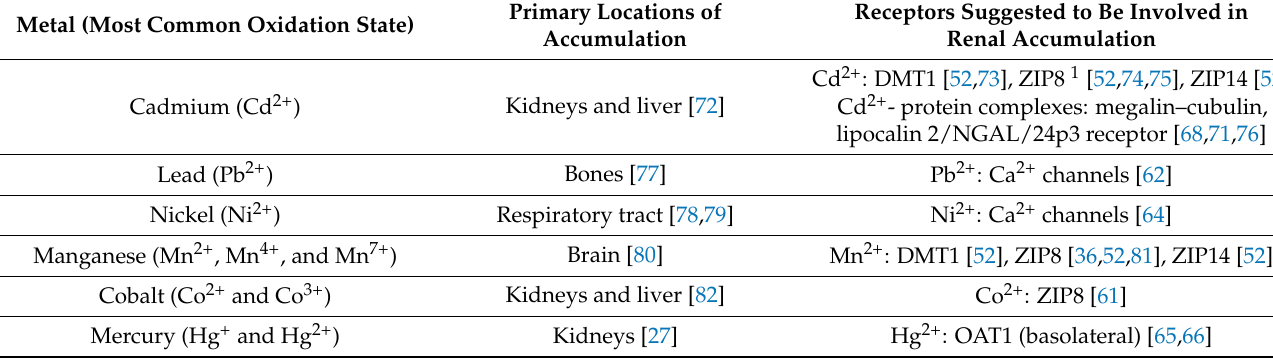
Table 1. An overview of divalent metal ions linked to